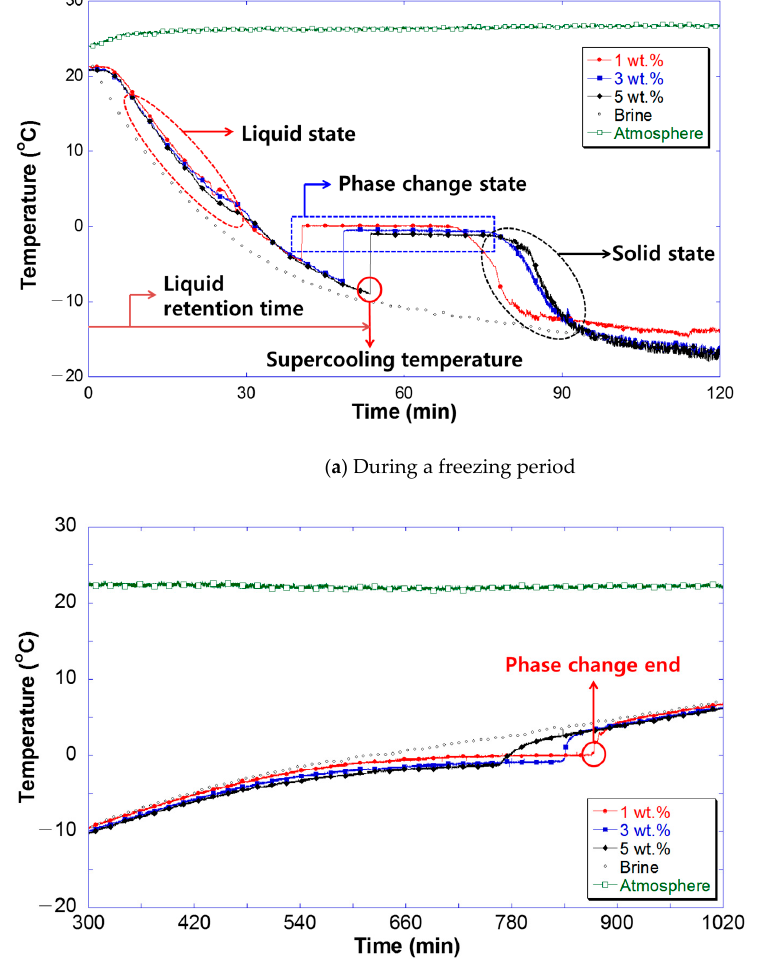
Figure 5. Measured temperature of PCMs with different eutectic molten salt concentrations; 1 wt.%, 3 wt.% and 5 wt.% without SAP.